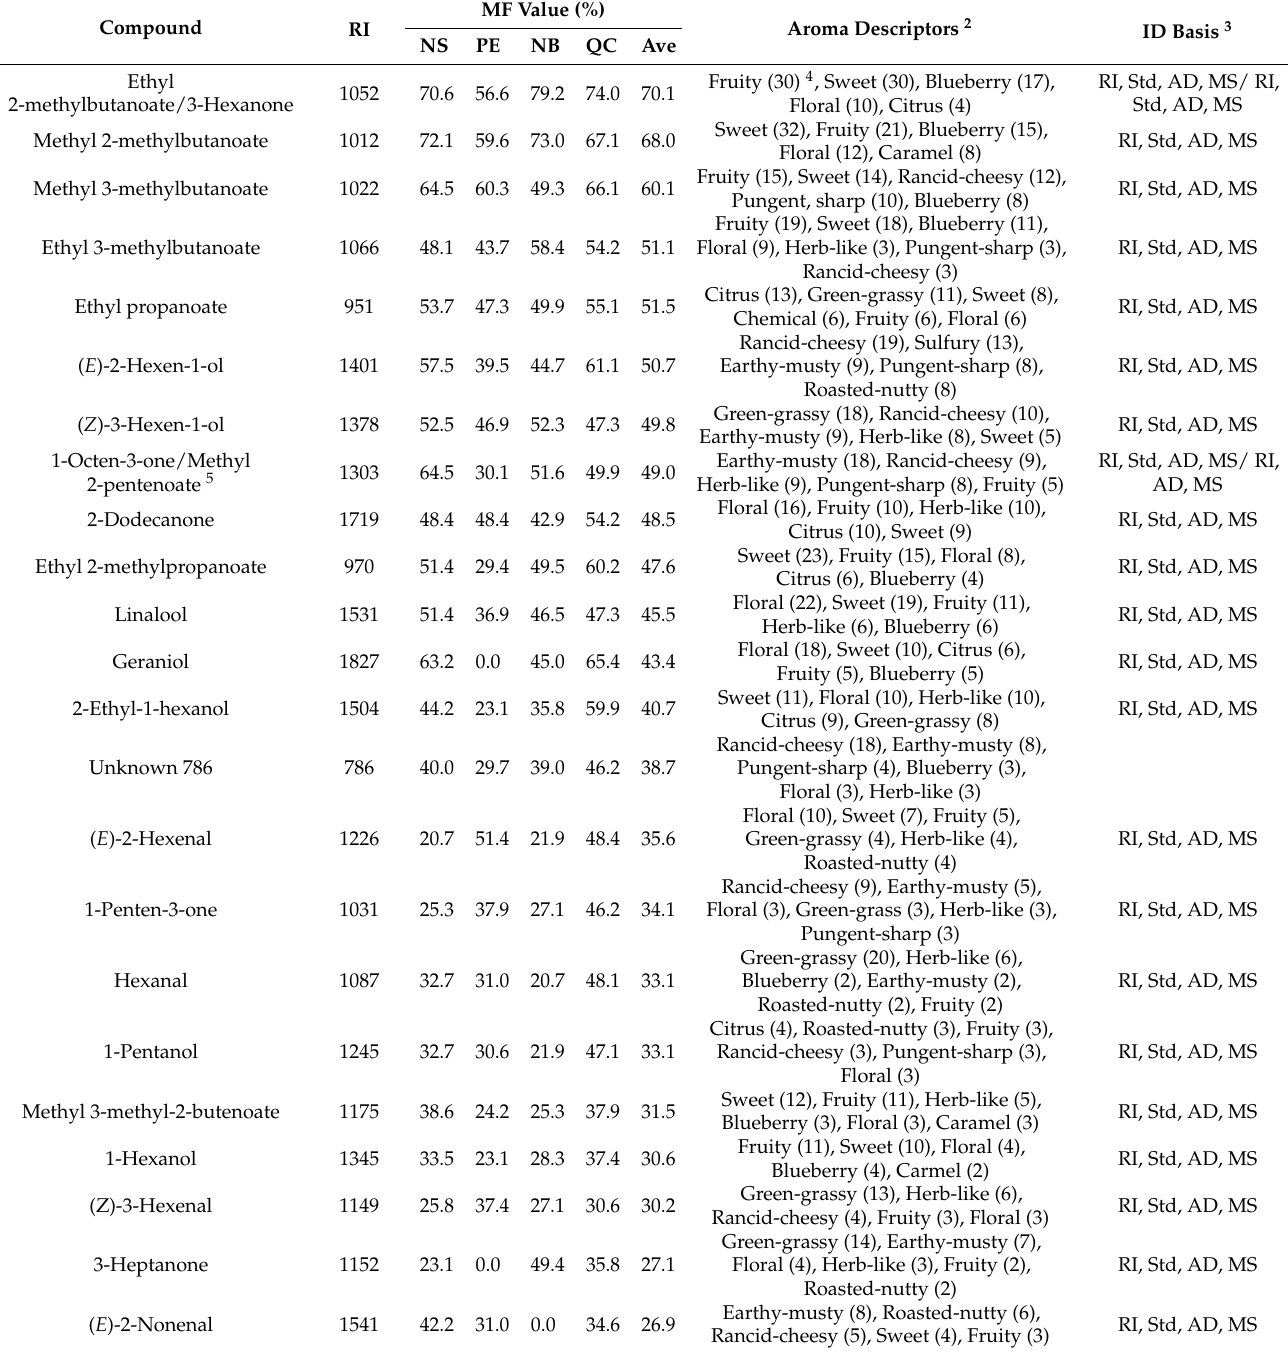
Table 1. Aroma-active compounds in wild lowbush blueberry fruit from the provinces of Nova Scotia (NS), Prince Edward Island (PE), New Brunswick (NB) and Quebec (QC) identified through gas chromatography-olfactometry (GC-O) and ranked by average modified frequency (MF) values 1